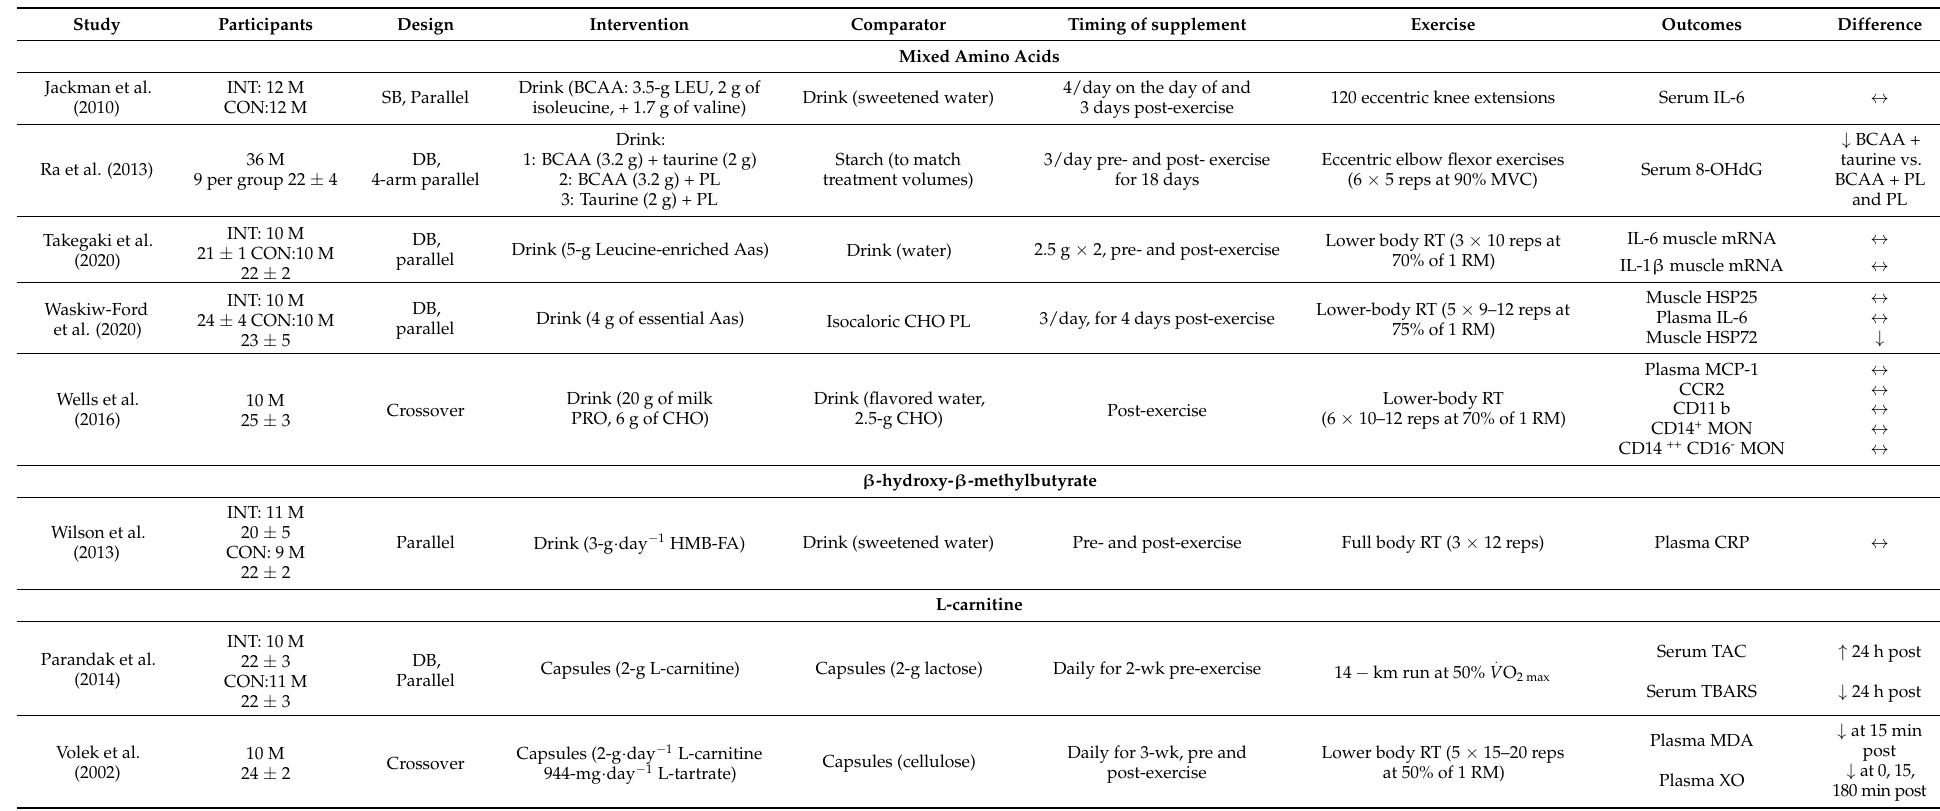
Table 2. Studies examining the effects of various amino acids on the markers of exercise-induced inflammation and oxidative stress. The Difference column denotes intervention vs.